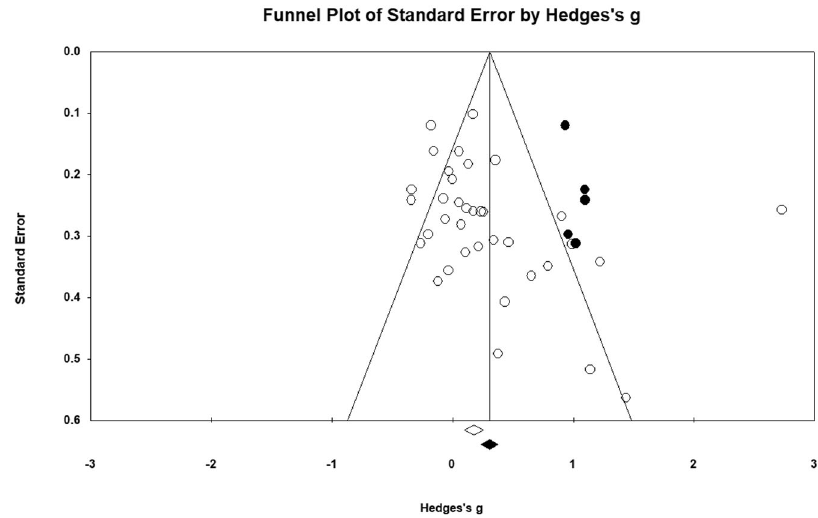
Fig. 3 Funnel plot of standard error by Hedges ’ g with imputed studies. The observed studies ( n = 36) are shown as open circles and the observed Hedges ’ g is shown as an open diamond at 0.28 [0.10 – 0.46]. The fi ve imputed studies are shown as fi lled circles and the imputed Hedges ’ g is shown as a fi lled diamond at 0.38 [0.20 –